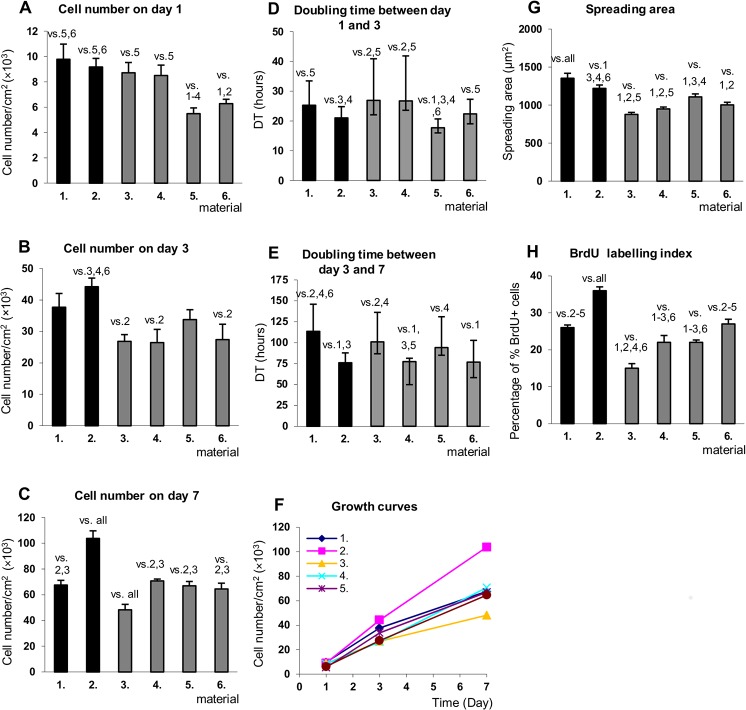
Density of CPAE cells on day 1 (A), 3 (B) and 7 (C), doubling time between day 1 and 3 (D) and between 3 and 7 (E), growth curves (F), cell spreading area on day 1 (G) and BrdU labelling index on day 3 (H) on different surfaces.(1) tissue culture polystyrene (TCPS); (2) TCPS with 10 ng/mL of FGF-2sol in media (TCPS_FGF-2sol); (3) (Alb/Hep)2; (4) (Alb/Hep)2 with 10 ng/mL of FGF-2sol in media ((Alb/Hep)2FGF-2sol); (5) (Alb/Hep)2 with FGF-2ads adsorbed (30 ng/cm2, (Alb/Hep)2FGF-2adsLow); (6) (Alb/Hep)2 with FGF-2ads adsorbed (120 ng/cm2, (Alb/Hep)2FGF-2adsHigh). The cells were cultivated in 5% FBS media. The data is expressed as mean ± S.E.M (A-C, F-H) and median ± quartiles (D, E); Statistically significant differences (p < 0.05) between surfaces (denoted in numbers) are depicted above bars.